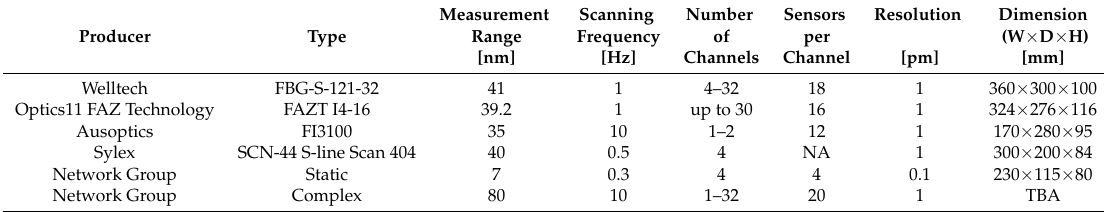
Table 1. Comparison of commercially available units with the home-developed system [19–23].